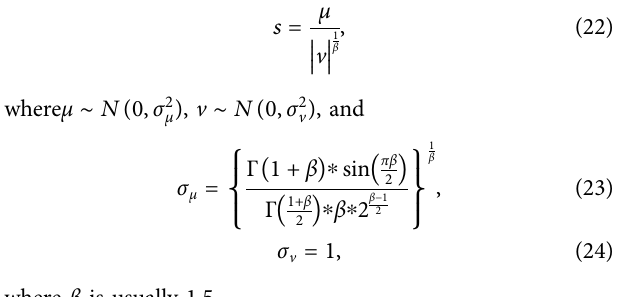
FIGURE 3 | Block diagram of the PSO